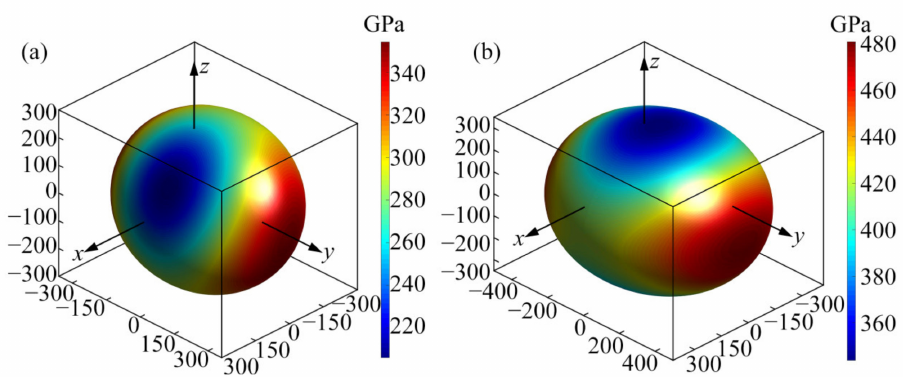
Figure 6. The 3D directional dependence of B : ( a ) η (cid:48) -Cu 6 Sn 5 ; ( b ) Cu 3 Sn.